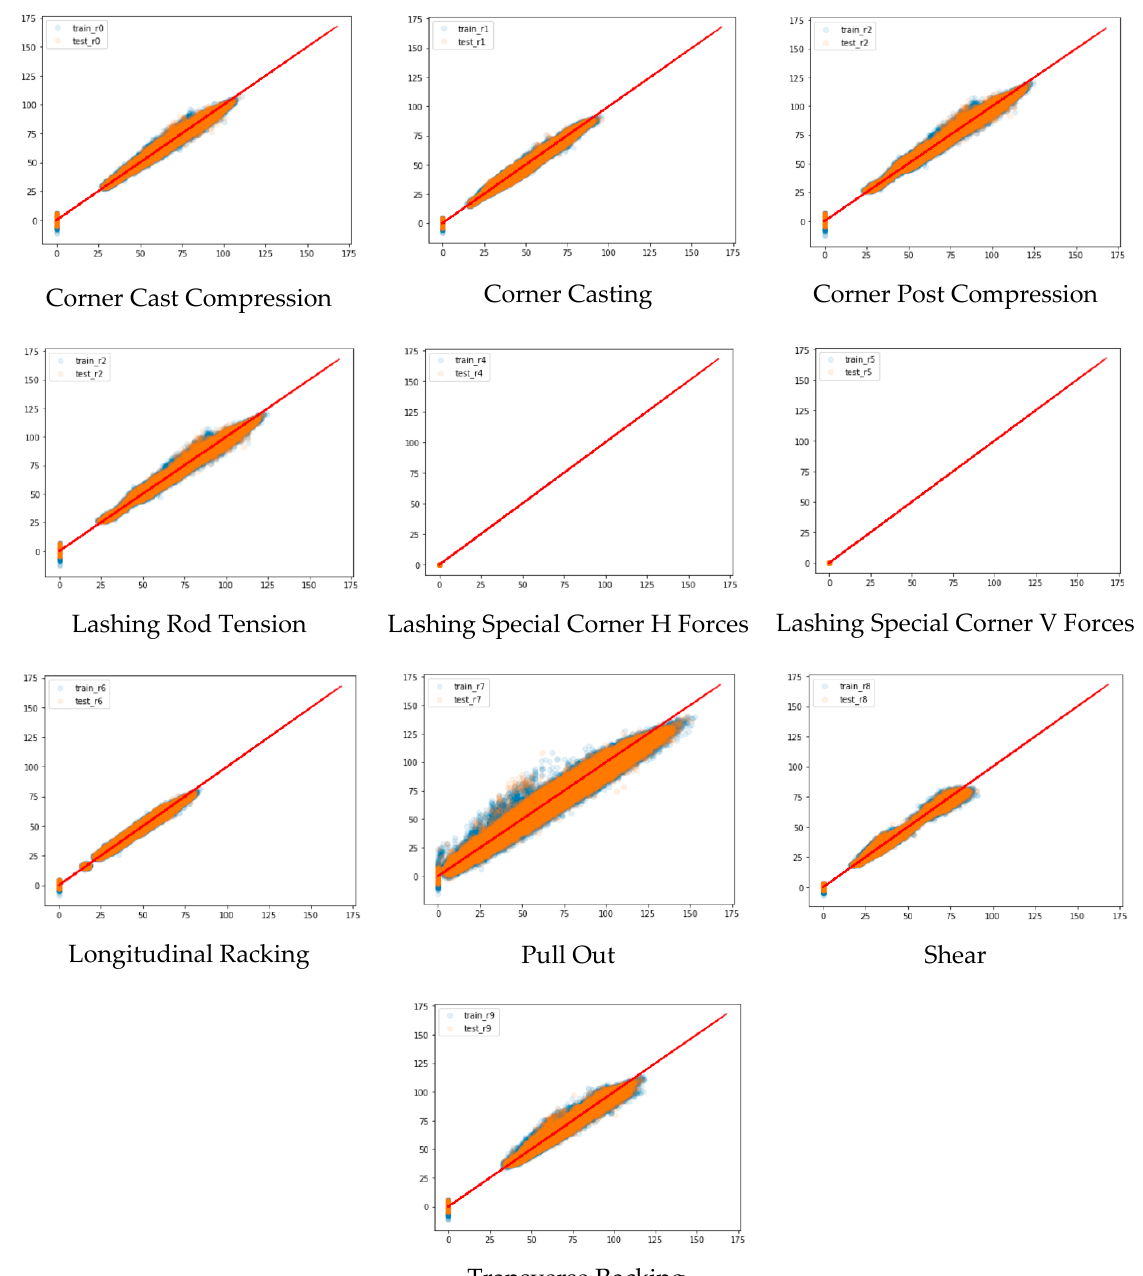
Figure 11. Individual lashing force component test result against training result. X axis = label, Y axis = predicted value, blue dot = training result, orange dot = test result.